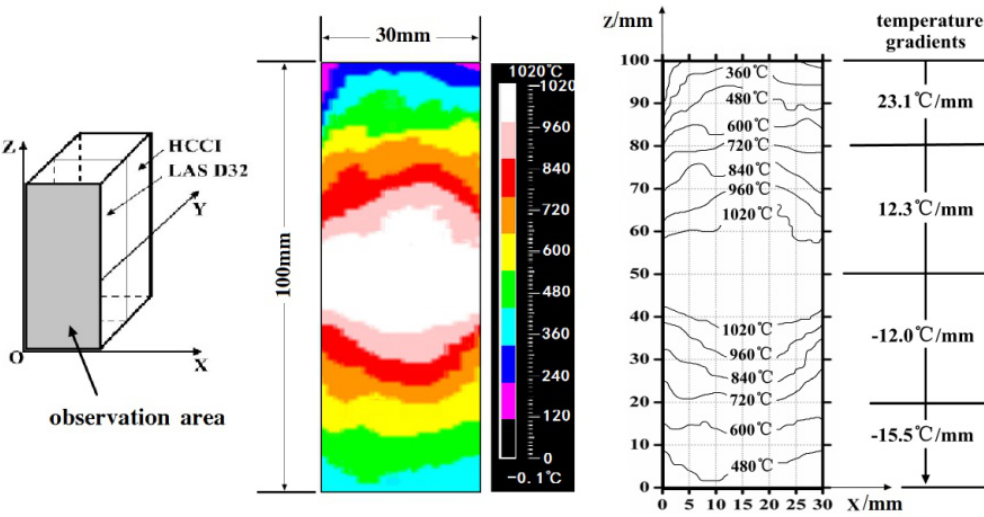
Figure 4. Temperature filed of the back surface of D32 during the electroslag surfacing processing.